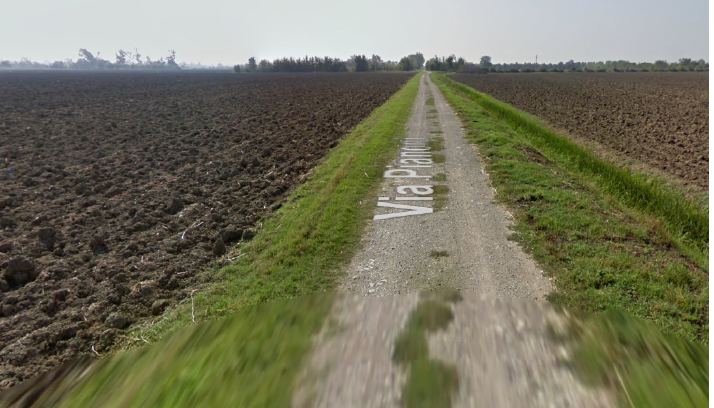
Figure 10. Gravel track considered in one of the offroad calibration tests (Via Pianoni, Fabbrico,